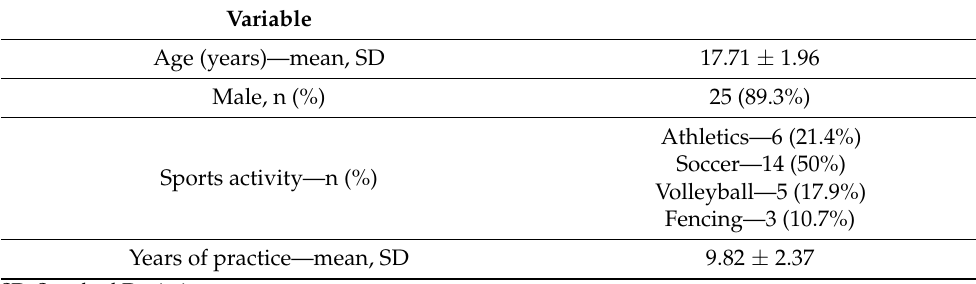
Table 1. Characteristics of the sample size (n =